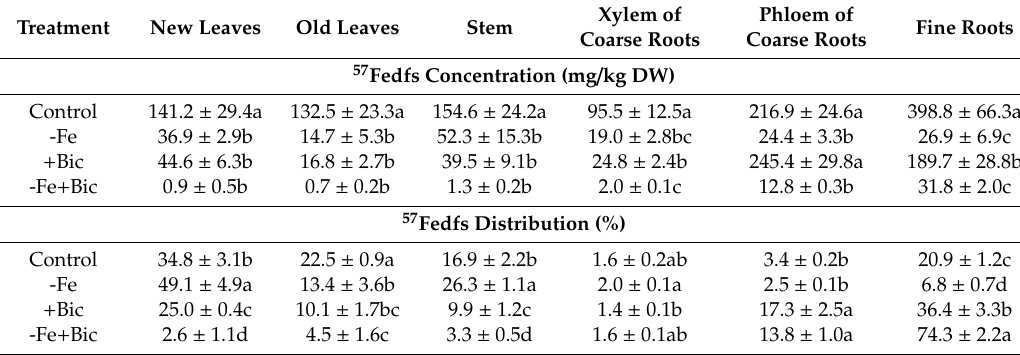
Table 2. 57 Fedfs translocation differences in various parts of kiwifruit plants treated with -Fe, +Bic or -Fe+Bic in solution culture for 28 days. Values are means of three replicates ± SE. Different letters indicate significant differences among the treatments at P < 0.05. NL, new leaves; OL, old leaves; S, shoots; R, roots; XCR, xylem of coarse roots; FR, fine roots.